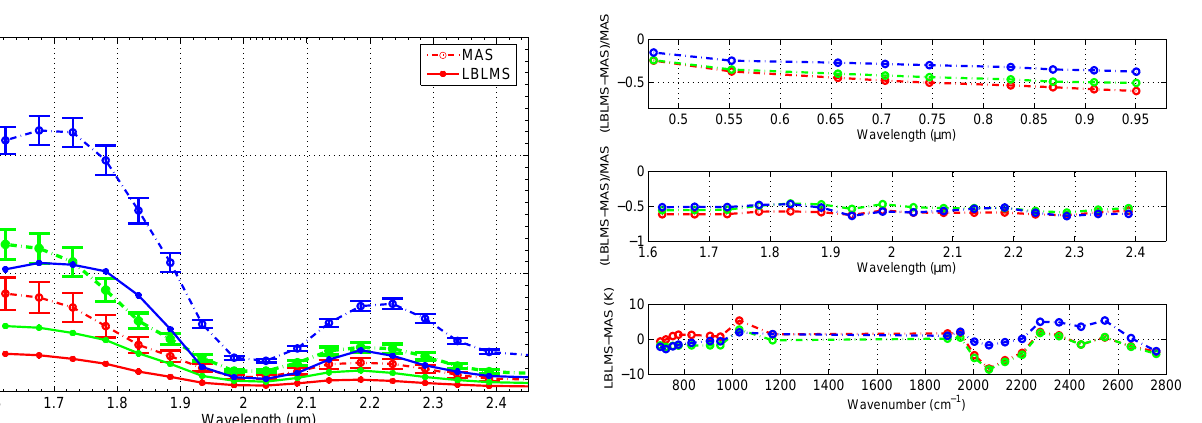
Fig. 12. LBLMS simulations and MAS observations in cloudy con- ditions – SW range. The three colours represent the three sections highlighted in Fig. 10: red for the thin cloud layer, green for the medium cloud layer and blue for the moderately thick layer. The vertical bars have same meaning as in Fig. 11.